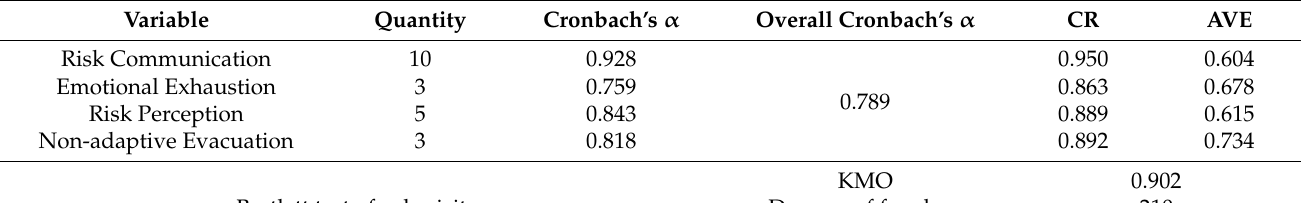
Table 2. Reliability and validity test.